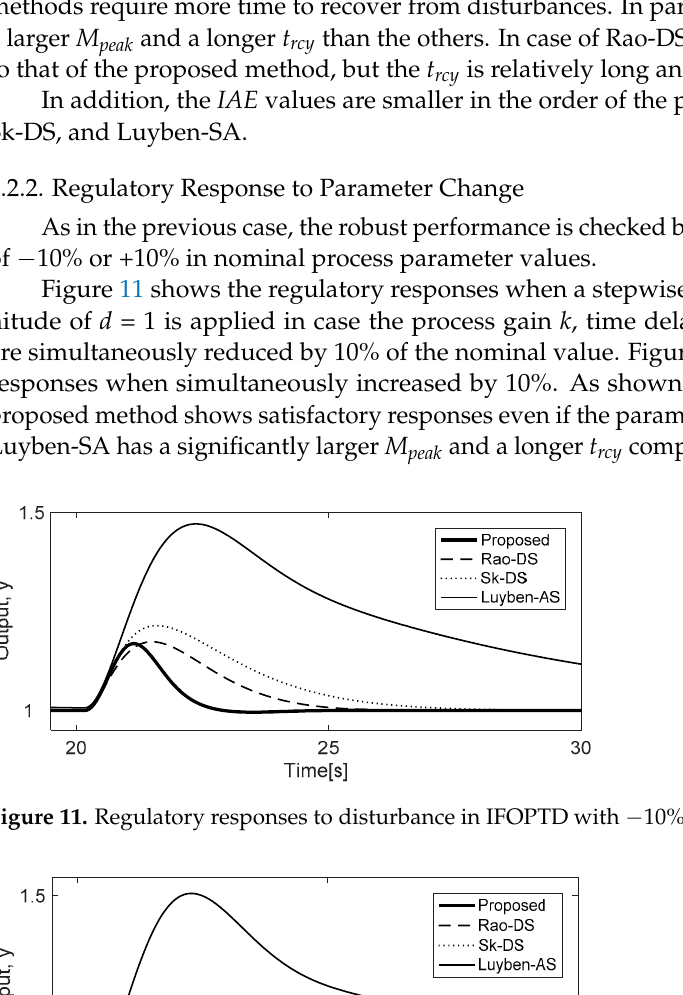
Figure 10. Regulatory responses to disturbance in perfect model of IFOPTD. Table 7. Quantitative comparison of responses to disturbance in perfect model of IFOPTD.